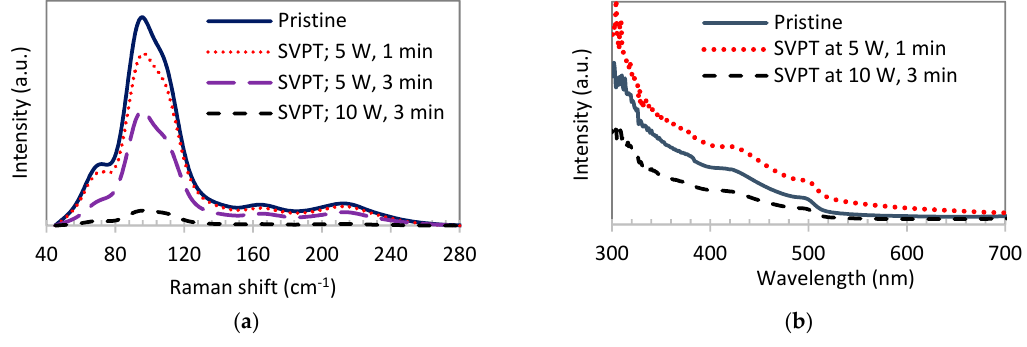
Figure 7. ( a ) Raman spectra and ( b ) UV-vis absorption spectra of the pristine sample and the samples subjected to the SVPT.